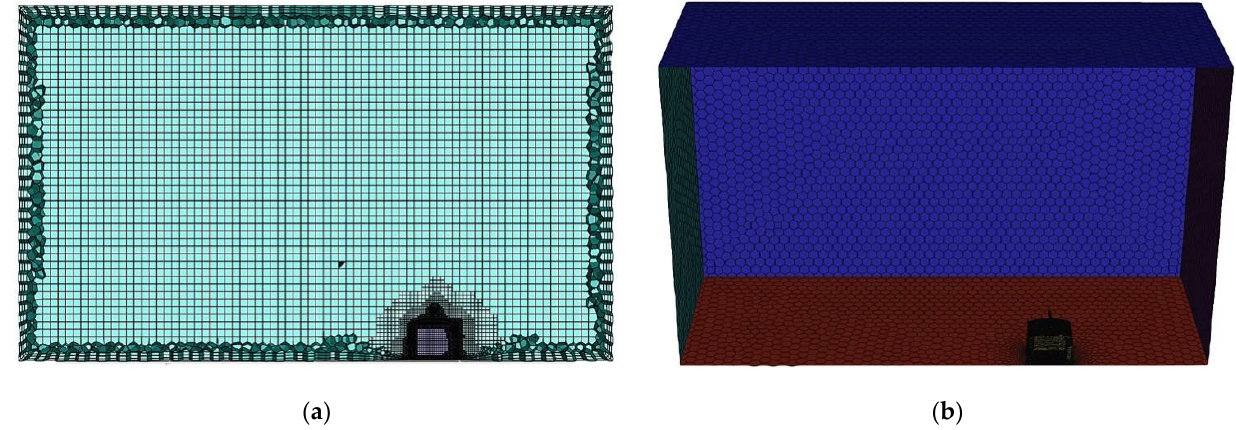
Figure 7. Computational fluid dynamics (CFD) meshing (2#). ( a ) Volume mesh; ( b ) surface mesh.